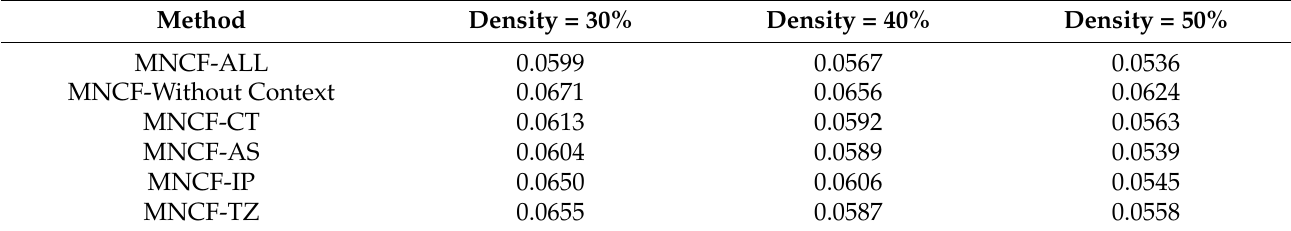
Table 4. Performance of RMSE with Different Contexts (MaxBlockBack = 100, MaxRTT =